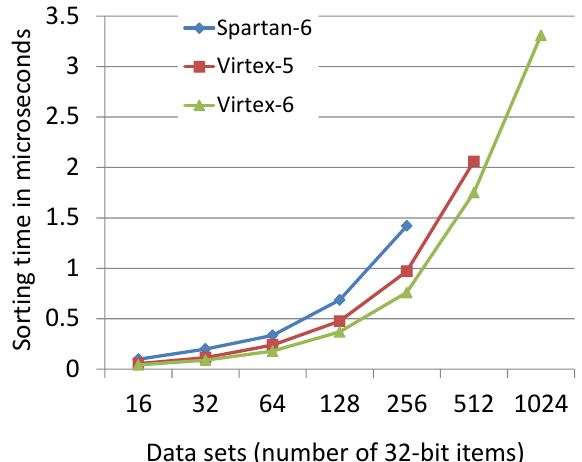
Fig. 10. The results of synthesis and implementations of data sorters for small sets of data